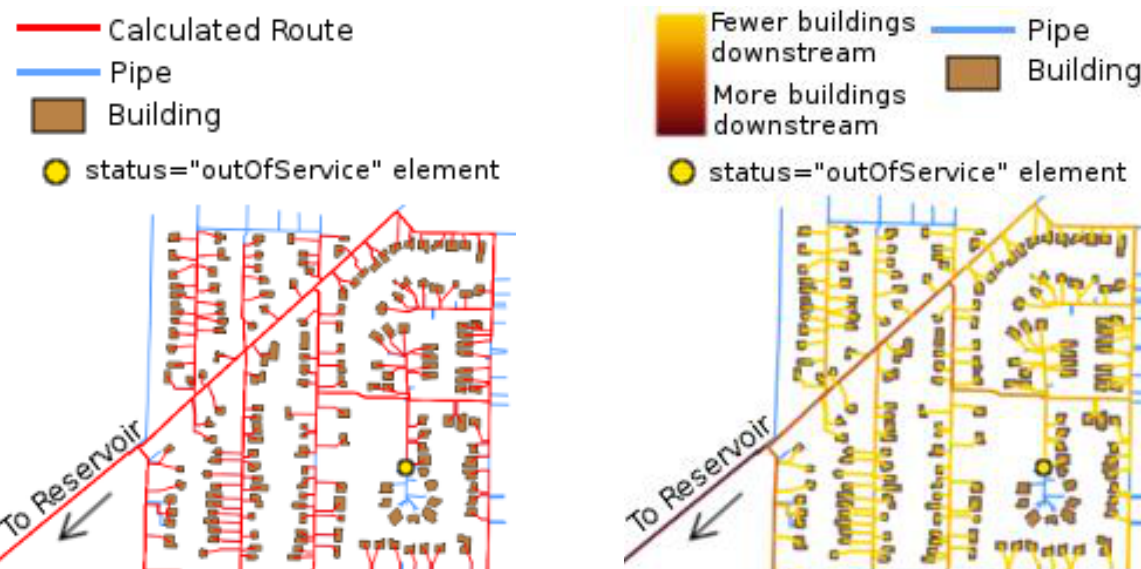
Figure 6. Visual representation of the least-cost path from the reservoir to the buildings (left). Visual representation of the stress on each link in the network along the routing of the reservoir to the buildings (right). Both examples are obtained using a subset of the Nanaimo data sample from Boates